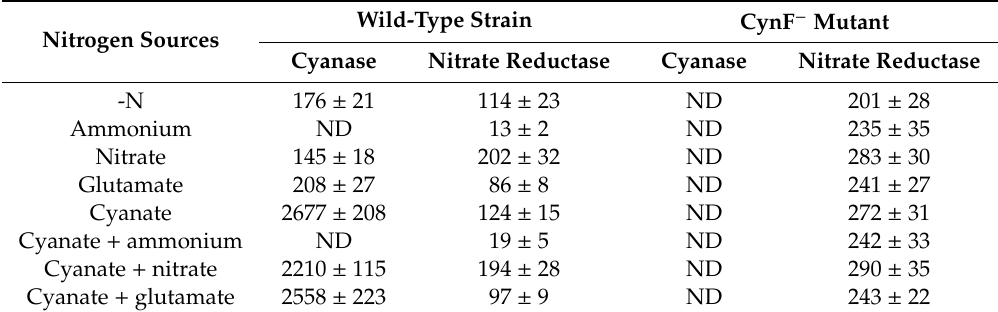
Table 1. Cyanase and nitrate reductase activities in the wild-type and CynF − mutant strains of P. pseudoalcaligenes CECT5344 grown with di ff erent nitrogen sources. Wild-Type Nitrogen Sources